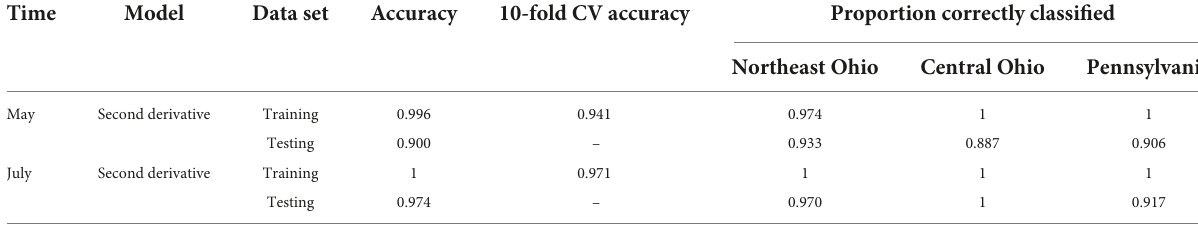
BER,balancederrorrate. TABLE 4 Accuracies of the support vector machine (SVM) model used to classify leaf near-infrared (NIR) spectra based on site location for the May and July datasets. Time Model Data